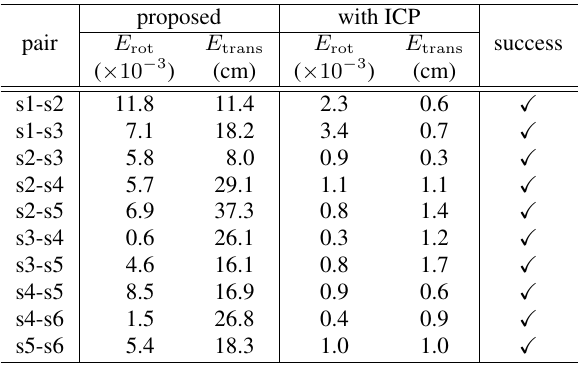
Table 3. Accuracy for Trees dataset